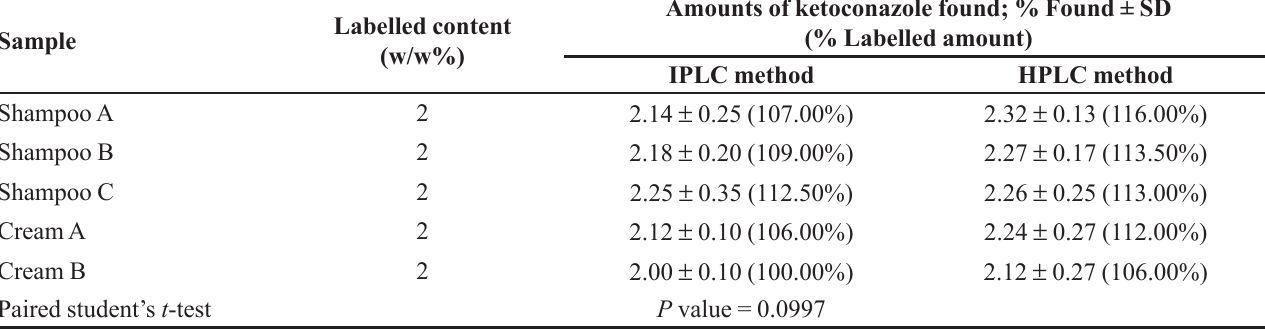
TABLE V - Comparison of the proposed IPLC method and the HPLC method for the determination of ketoconazole in shampoo and cream